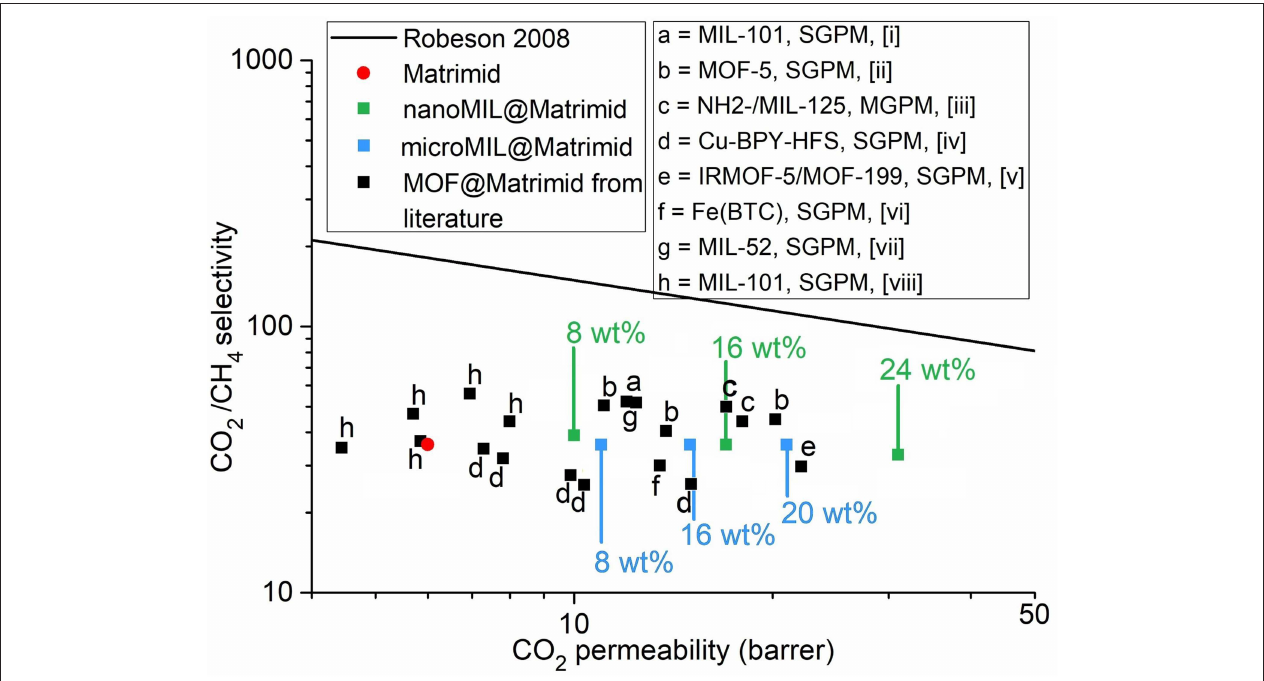
FIGURE 8 | CO 2 /CH 4 separation performance of nanoMIL-101Cr@Matrimid (green), microMIL-101Cr@Matrimid (light blue), and neat Matrimid (red) compared with published results for mixed-matrix membranes based on MOF@Matrimid (black). The upper bound for polymer performances as defined by Robeson in 2008 is given as a black line ( Robeson, 2008). SGPM = single-gas permeation measurement. MGPM, mixed-gas permeation measurement. References: a, (Rajati et al., 2018); b, ( Perez et al., 2009); c, (Anjum et al., 2016); d, (Zhang et al., 2008); e, (Nik et al., 2012); f, (Shahid and Nijmeijer, 2014); g, (Dorosti et al., 2014); and h, (Naseri et al., 2015).